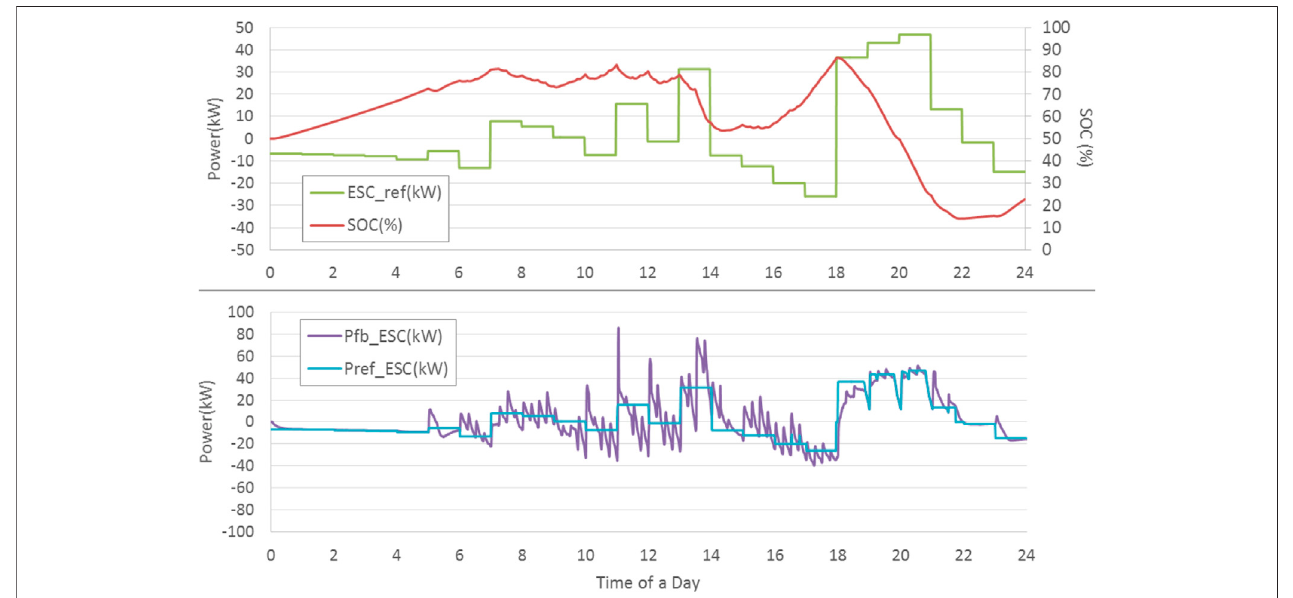
FIGURE 10 | Optimized energy storage converter (ESC) power and ESC power feedback using